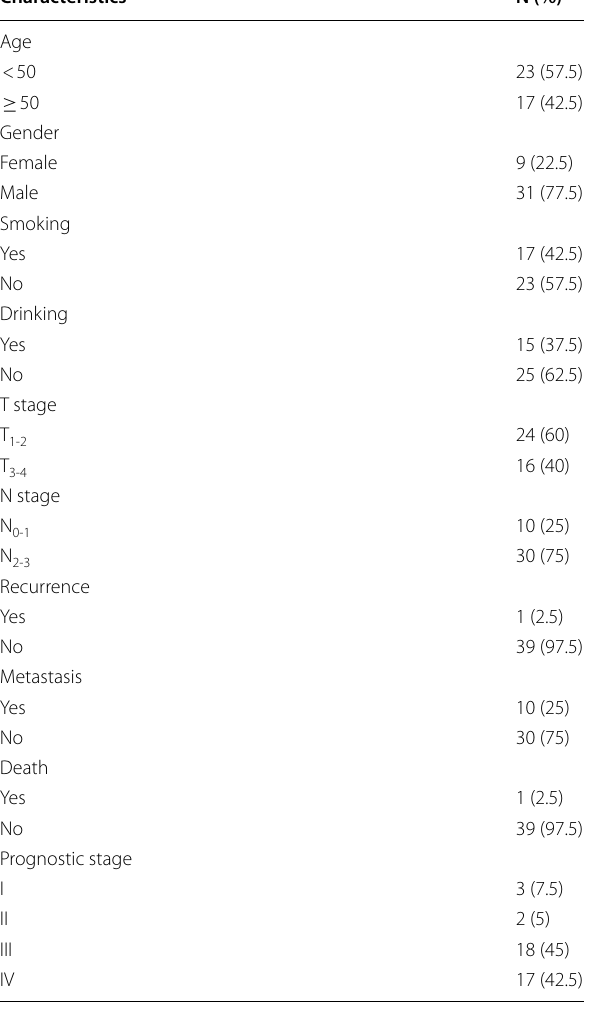
Table 1 Patient